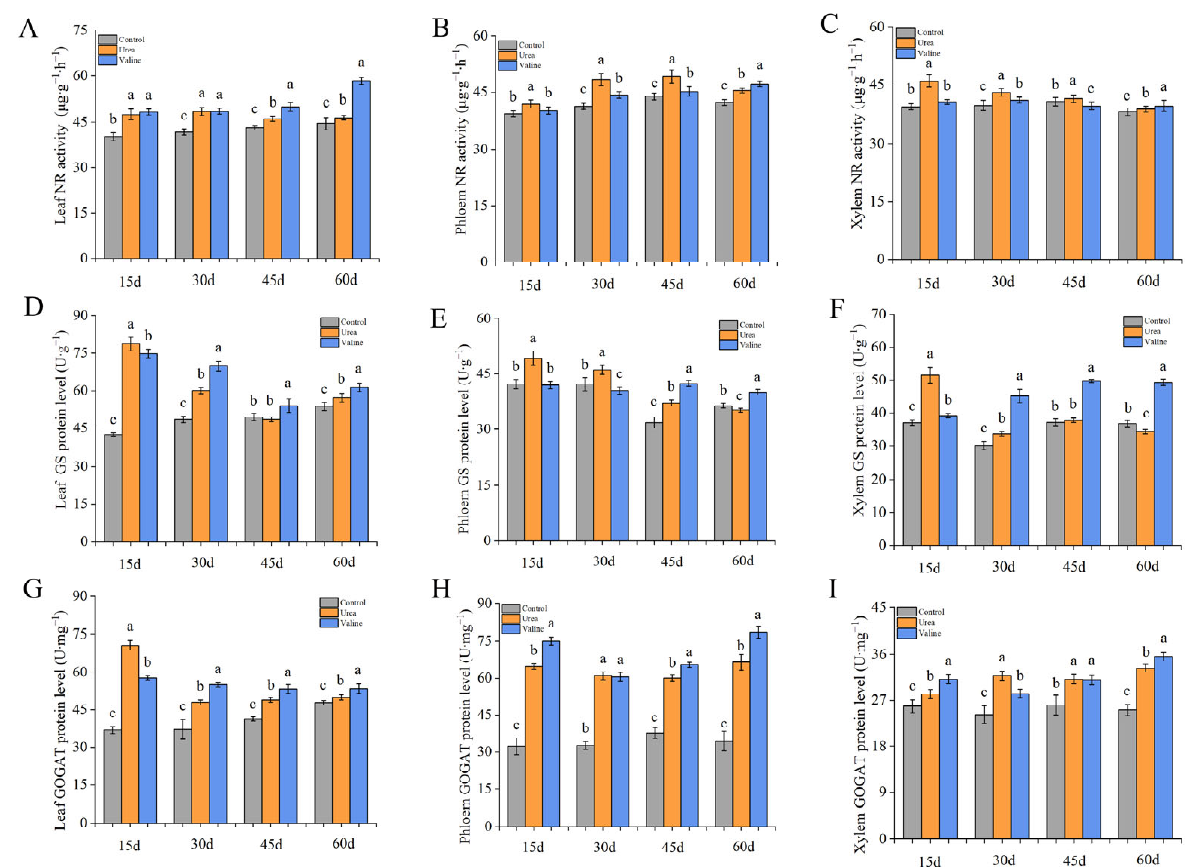
Figure 5. Effects of valine and urea on enzymes of nitrogen metabolism in peach tree. ( A ) Leaf NR activity. ( B ) Phloem NR activity. ( C ) Xylem NR activity. ( D ) Leaf GS protein level. ( E ) Phloem GS protein level. ( F ) Xylem GS protein level. ( G ) Leaf GOGAT protein level. ( H ) Phloem GOGAT pro- tein level. ( I ) Xylem GOGAT protein level. The error bar represents the standard deviation of the mean ( n = 3). Di ff erent lowercase le tt ers indicate signi fi cant di ff erences among treatments (Duncan test, p < 0.05).